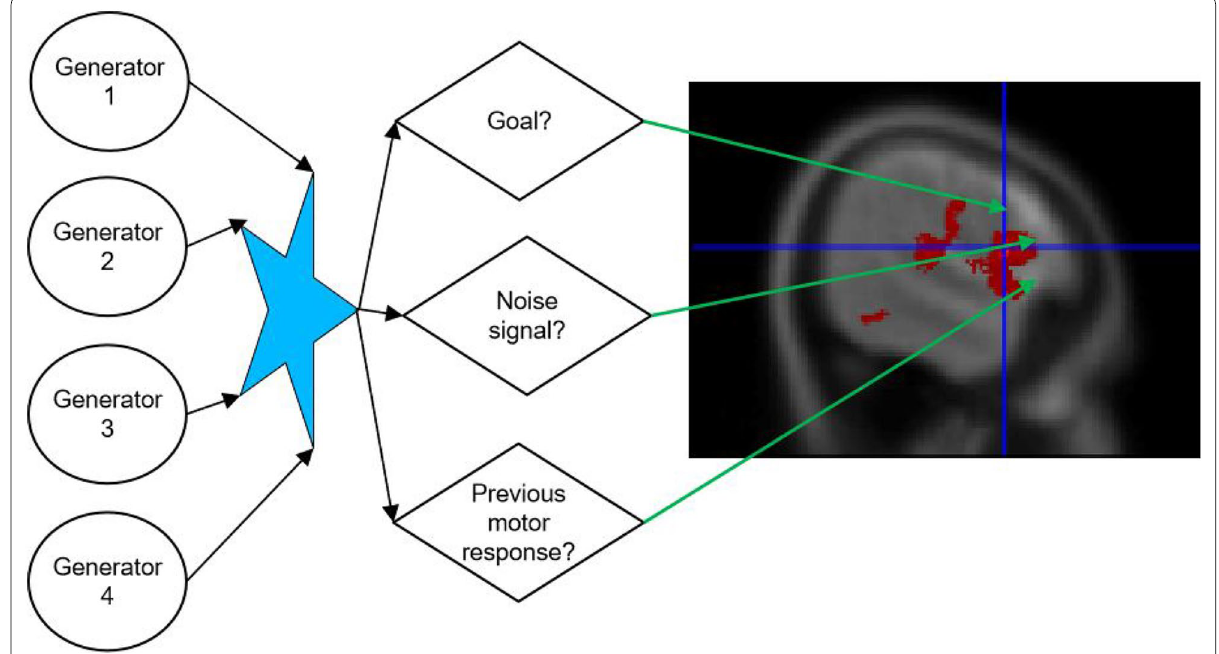
Fig. 6 Modelling of number of prefrontal areas activated by several generators, where motor response modulated brain areas